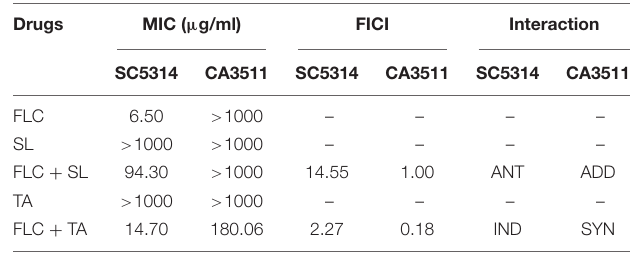
TABLE 2 | Antifungal activity of TA and SL against C. albicans ( n = 3).